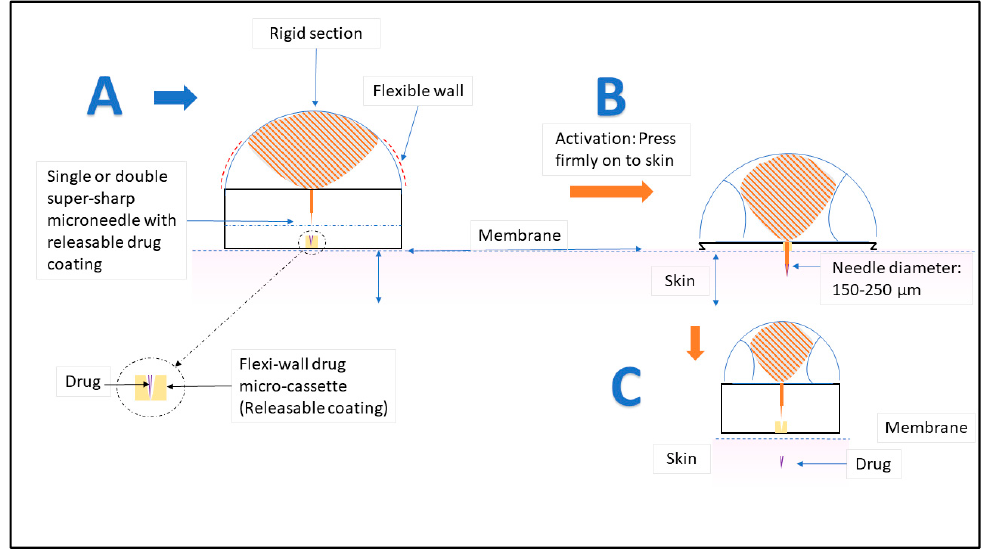
Figure 7. Delivery using the Nemaura solid dose delivery system (Modified from Fig. 2 of Reference [3] with permission from Nemaura Pharma Ltd, Loughborough, UK).